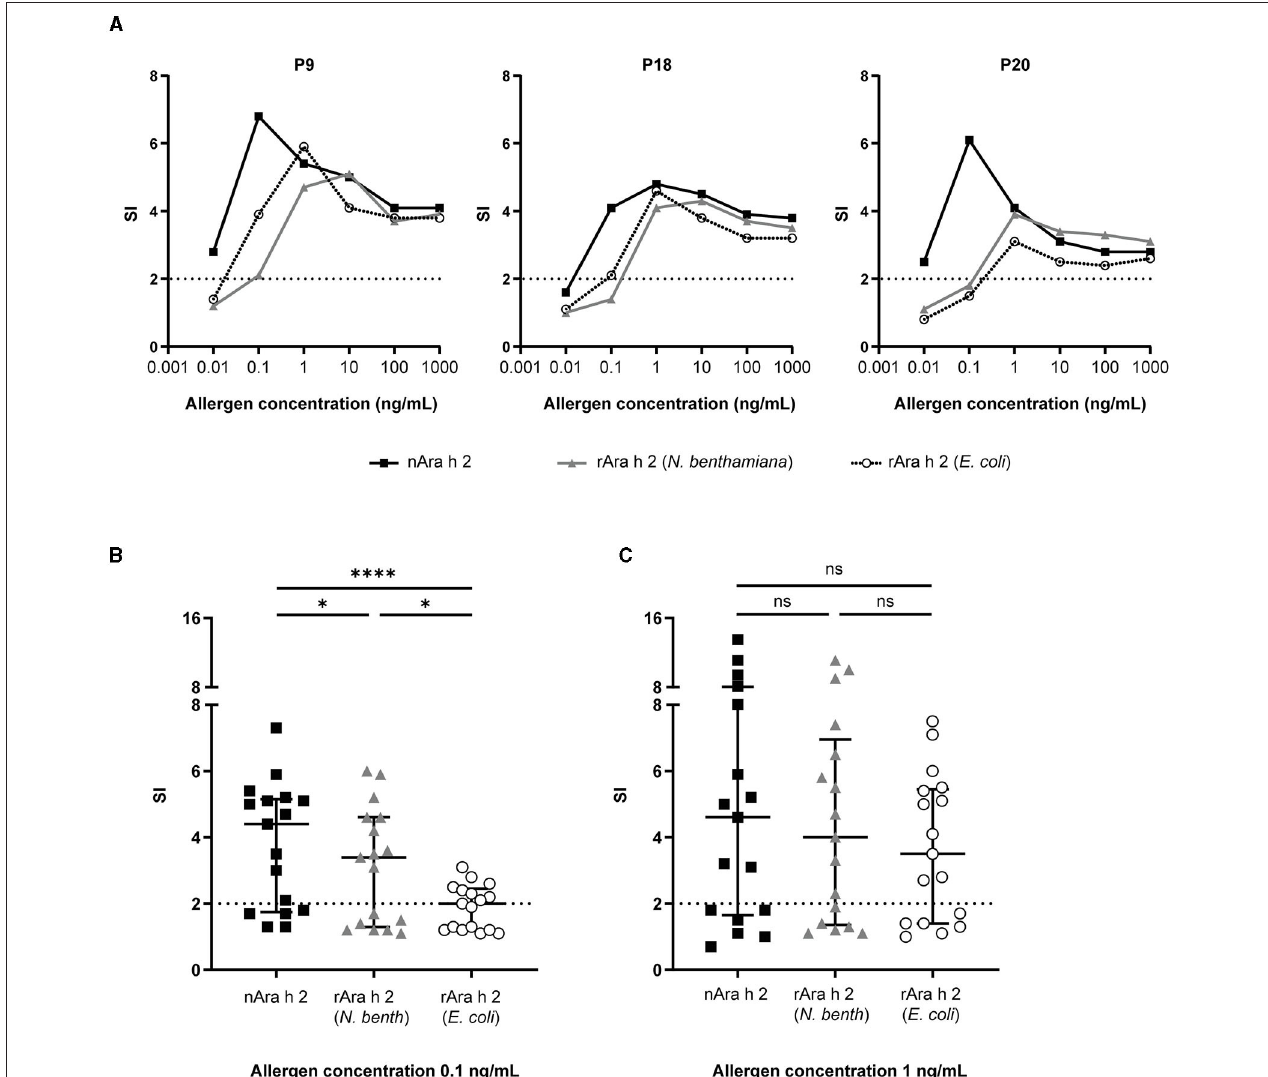
FIGURE 5 | RBL assays were performed to investigate the IgE cross-linking capacity of rAra h 2 from N. benthamiana in comparison with the nAra h 2 and the rAra h 2 from E. coli . (A) Three patients (P9, P18, and P20) were selected to perform the allergen titrations. Data are the means of technical triplicates ( n = 3). Data are represented as stimulation indices (SI) calculated by dividing the luminescence values from antigen-treated cells with the ones from non-stimulated cells. A value above 2 was considered positive (indicated by dotted lines). (B) Data obtained from 17 peanut-allergic patients were used to compare the IgE-cross-linking performances of all Ara h 2 proteins at 0.1ng/mL allergen concentration. Median values and interquartile range are indicated. **** P ≤ 0.0001, * P ≤ 0.05. (C) As in (B) at 1ng/mL concentration. ns: P >